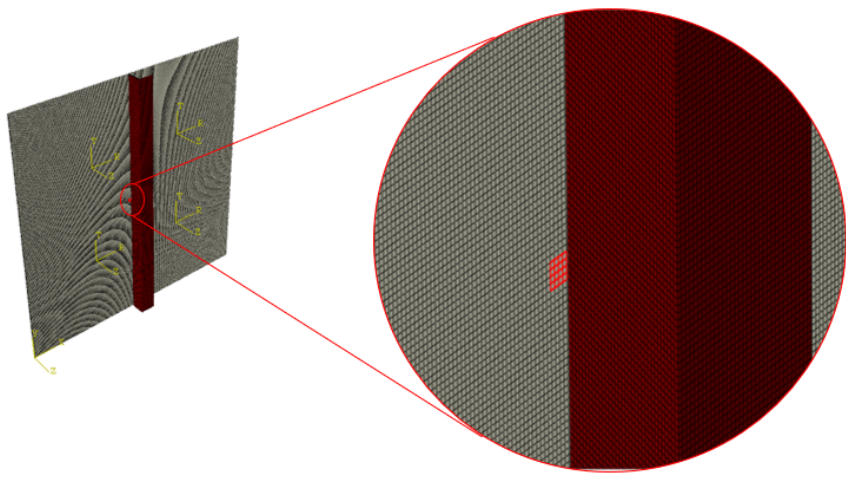
Figure 3. FE model of the stiffened panels and a focus on the elements set defined to evaluate the arrival instant of the wave in proximity of the stiffener. Table 3. FE modelling details for the stiffened panels.